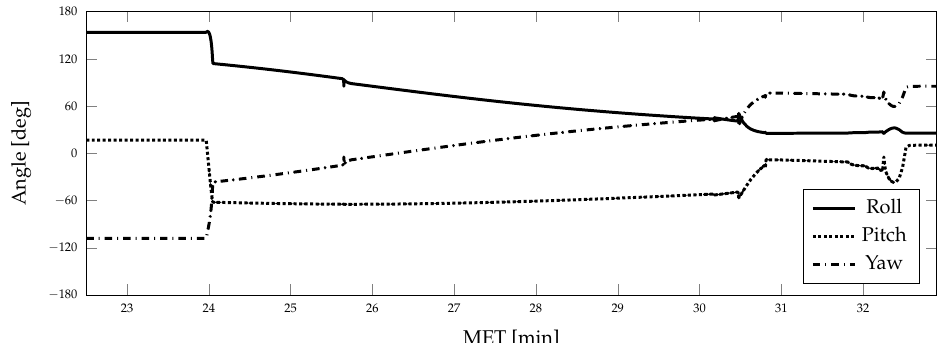
Table 1: Initial uncertainty for each state (per axis, 1 σ )